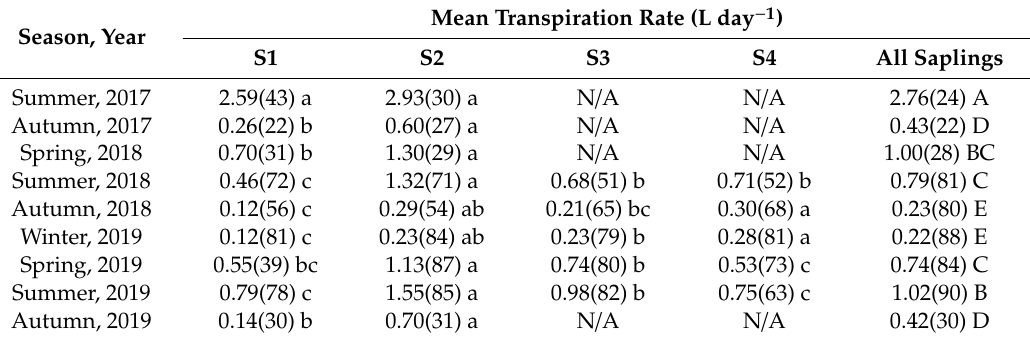
Table 3. Transpiration rates of juniper sapling in the treated Mays WS, averaged by individual sapling (S1–S4), and by all-saplings, for summer (1 July to 30 September), autumn (1 October to 31 December), winter (1 January to 31 March), and spring (1 April to 30 June), from July 2017 through October 2019. Di ff erent lowercase letters (a, b, c) along rows indicate significant di ff erences ( p ≤ 0.05) in mean transpiration rate by sapling for each season. Di ff erent uppercase letters (A, B, C, D, E) along the last column indicate mean transpiration di ff erences ( p ≤ 0.05) by season for all saplings. Numbers in parentheses in S1–S4 represent the number of days when sap flow data were collected for each individual tree. Numbers in parentheses for all saplings represent the number of averaged days using data from at least two saplings. N / A = Data not